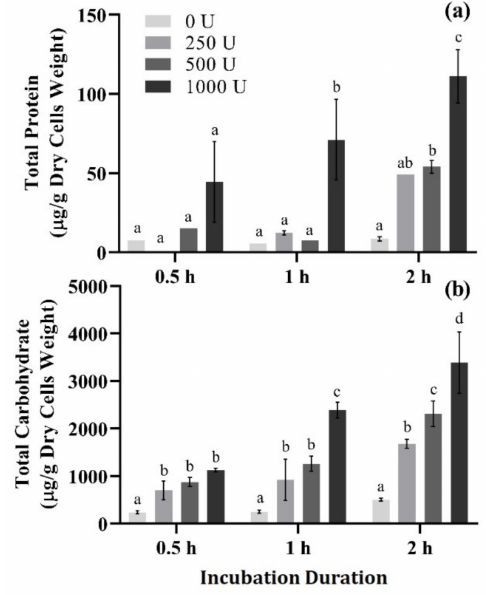
Figure 3. Total protein and carbohydrate content normalized by g dry weight cells of supernatant samples collected after enzymatic treatment of SB62 cell suspensions. Treatment variables included enzyme concentration (0, 250, 500 and 1000 U/g dry cells weight), and incubation duration (0.5, 1 and 2 h at 37 ◦ C). ( a ) Total protein determined by BCA protein quantification. ( b ) Total carbohydrate deter- mined by the phenol-sulphuric acid test. The data points shown are means for duplicate experiments and the error bars indicate standard deviation between replicates. Different letters indicate significant differences ( p < 0.05) between samples treated with different enzyme concentrations within each separate incubation duration as analyzed by two-way ANOVA and the Fisher’s LSD